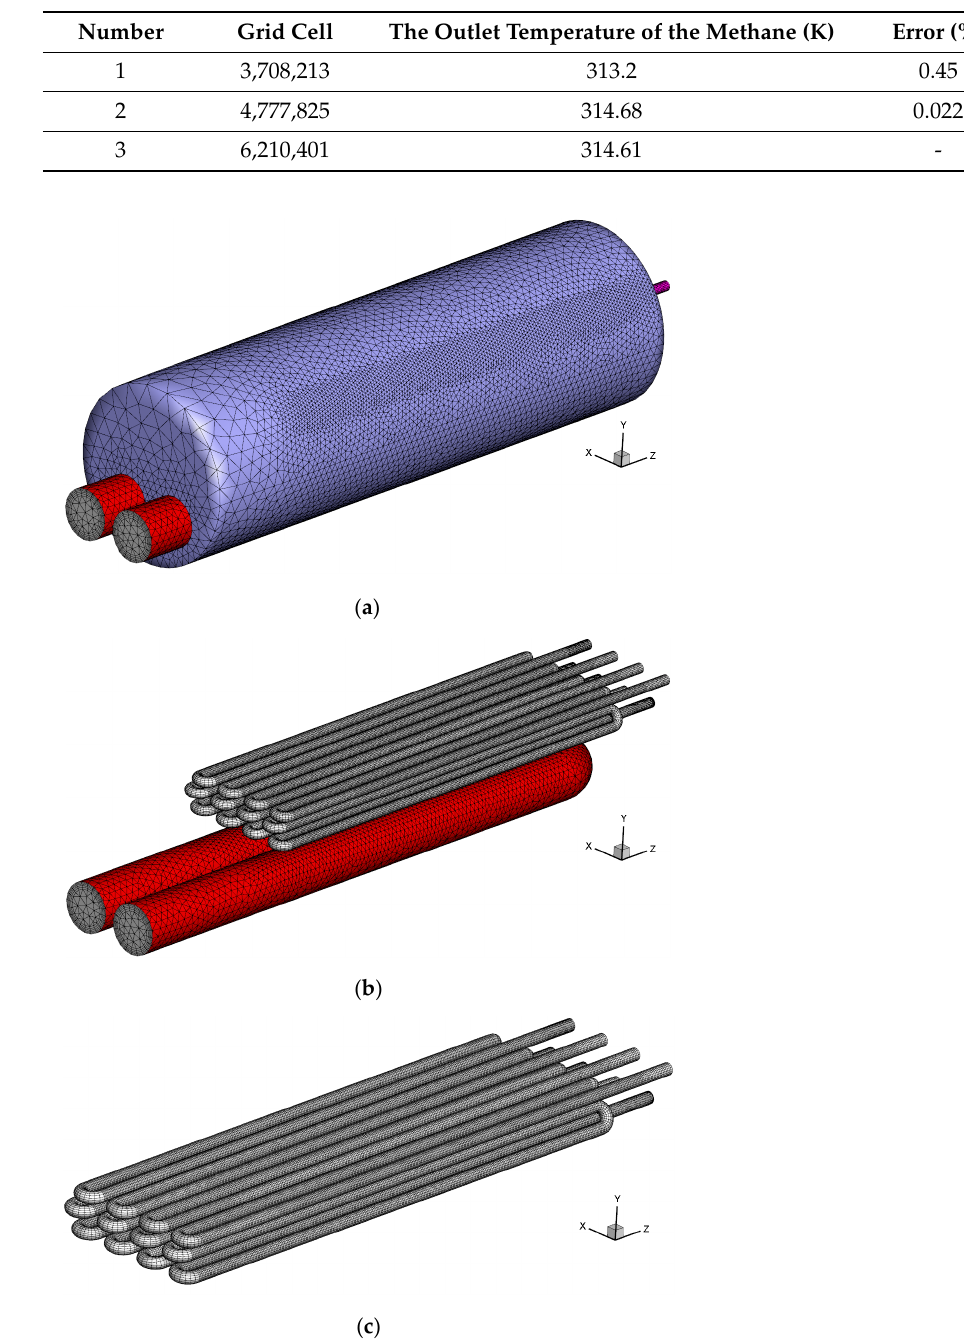
Table 4. The results of the mesh-independent analysis.